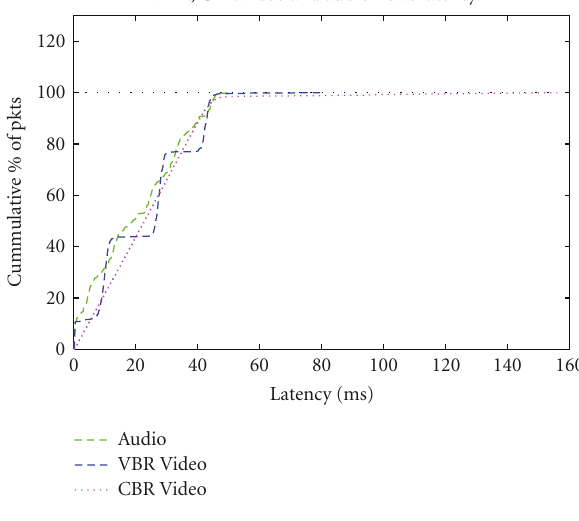
Figure 9: Latency distribution for FHCF.